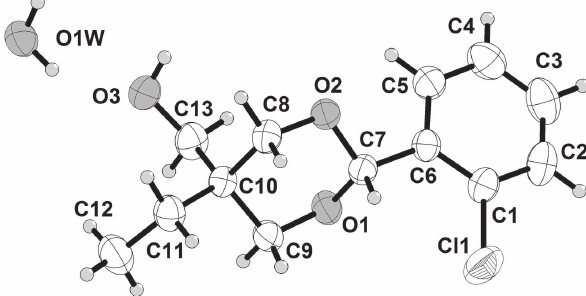
Table 1: Data collection and handling.